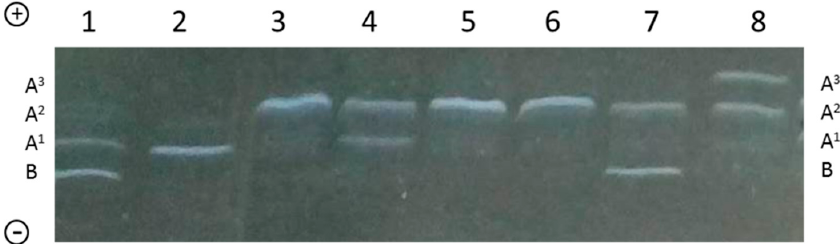
Figure 4. IEF analysis of individual milk samples from Italian Friesian cows. The β -CN variants are indicated on both gel sides. Sample 1: A 1 B; sample 2: A 1 A 1 ; samples 3, 5, 6: A 2 A 2 ; sample 4: A 1 A 2 ; sample 7: A 2 B; sample 8: A 2 A 3 .